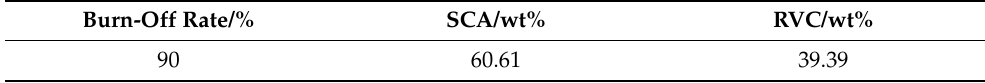
Table 3. Composition of simulated pulverized coal with 90% burn-off